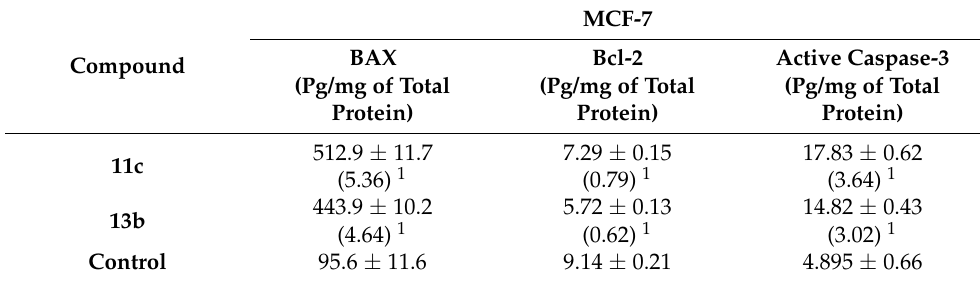
Table 5. Effect of QBS 11c and 13b on the expression levels of Bax, Bcl-2 and active Caspase-3 in breast cancer MCF-7